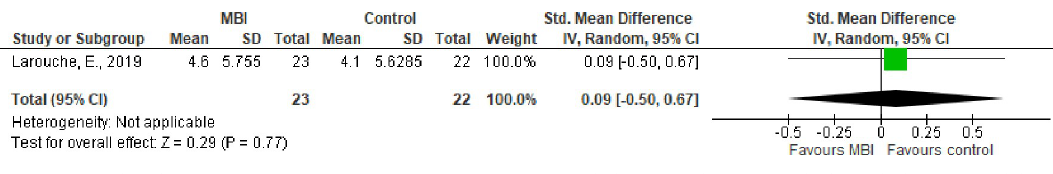
Fig 4. Forest plot of comparison: Anxiety symptoms, MBI versus control after 11 weeks to 6 months from the beginning of the intervention.